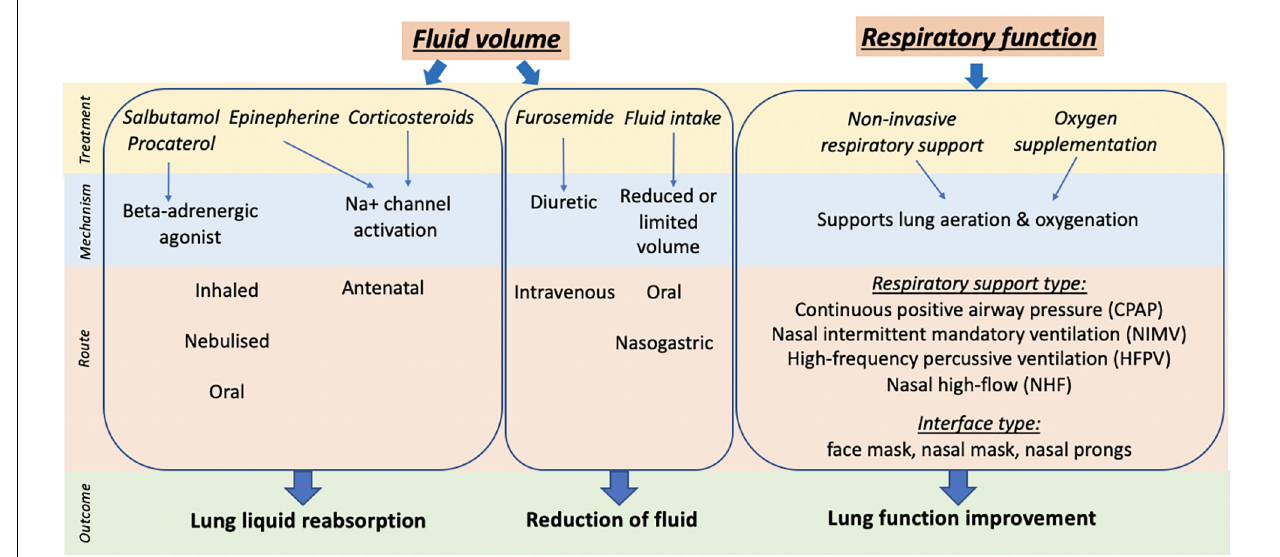
FIGURE 1 | Summary of clinical treatment, mechanism, route of action and outcome targeted for management of